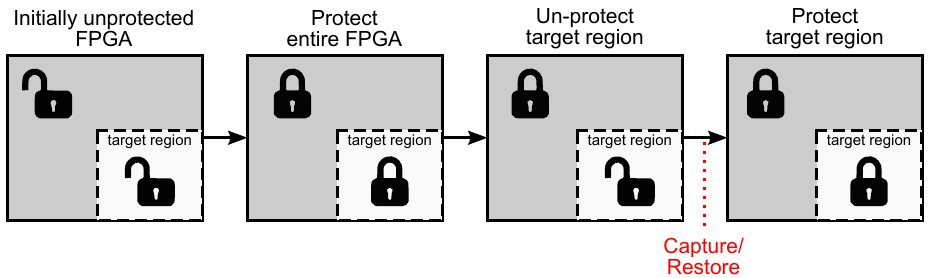
Figure 1. Flow chart of an FPGA protection and the unprotective alternative.